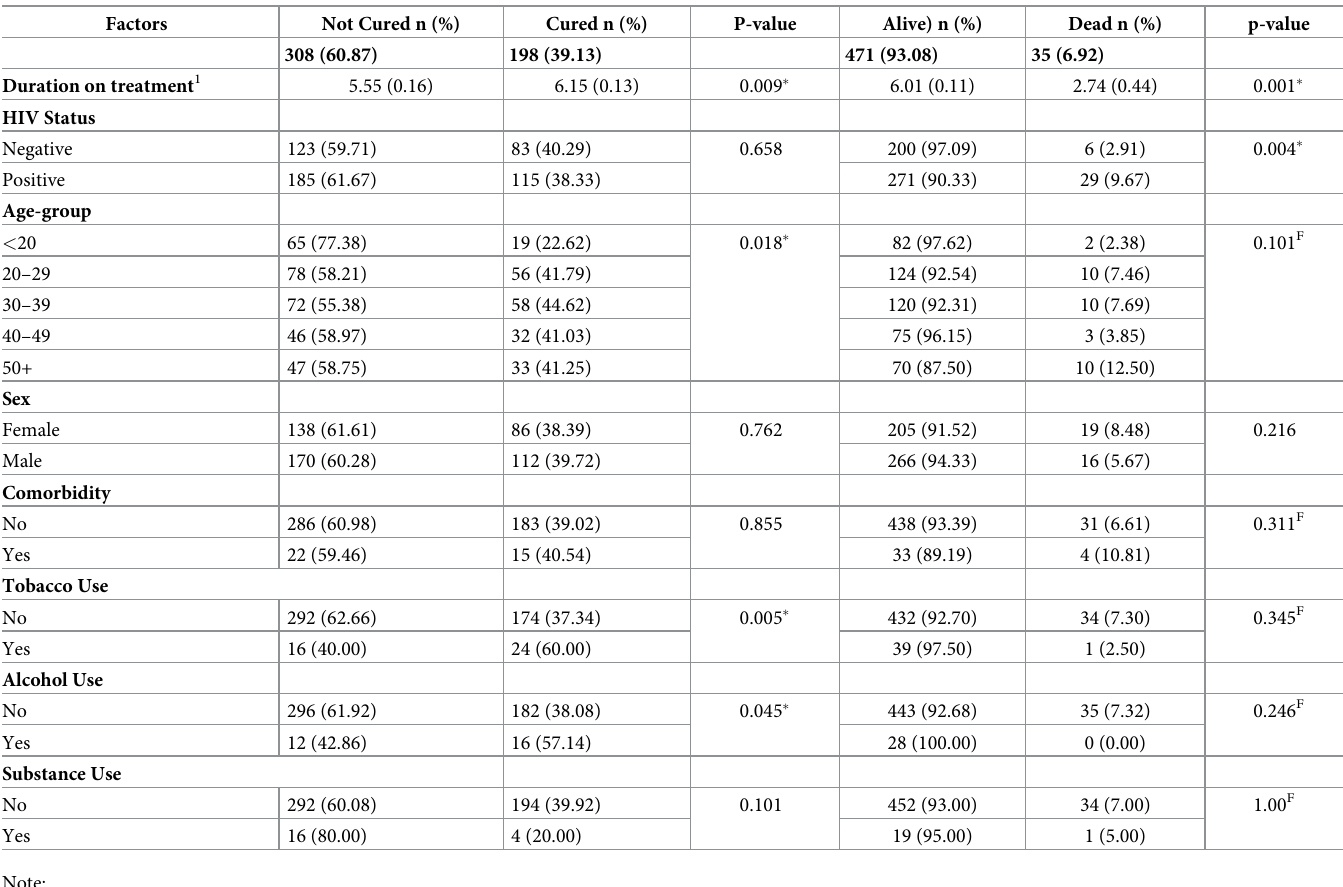
Table 1. Characteristics of TB patients presenting to Elim Clinic on the basis of TB cured